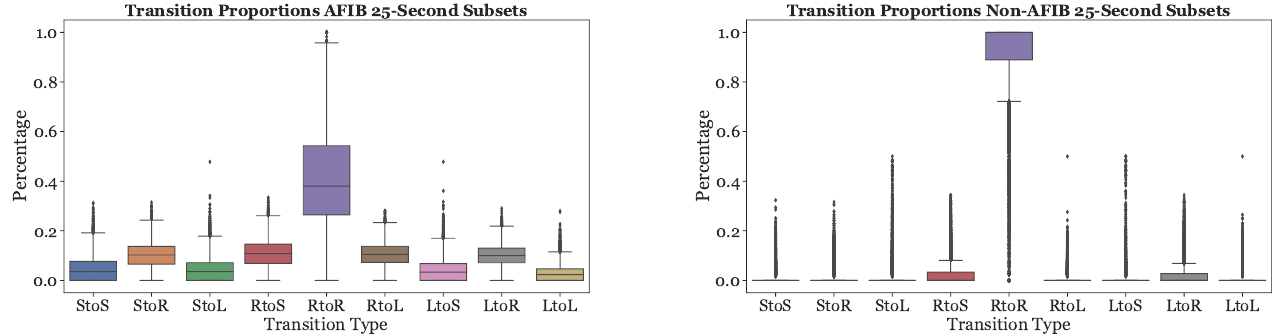
Figure 8. Transition frequencies across AFib and Non-AFib 25-s subsets for all